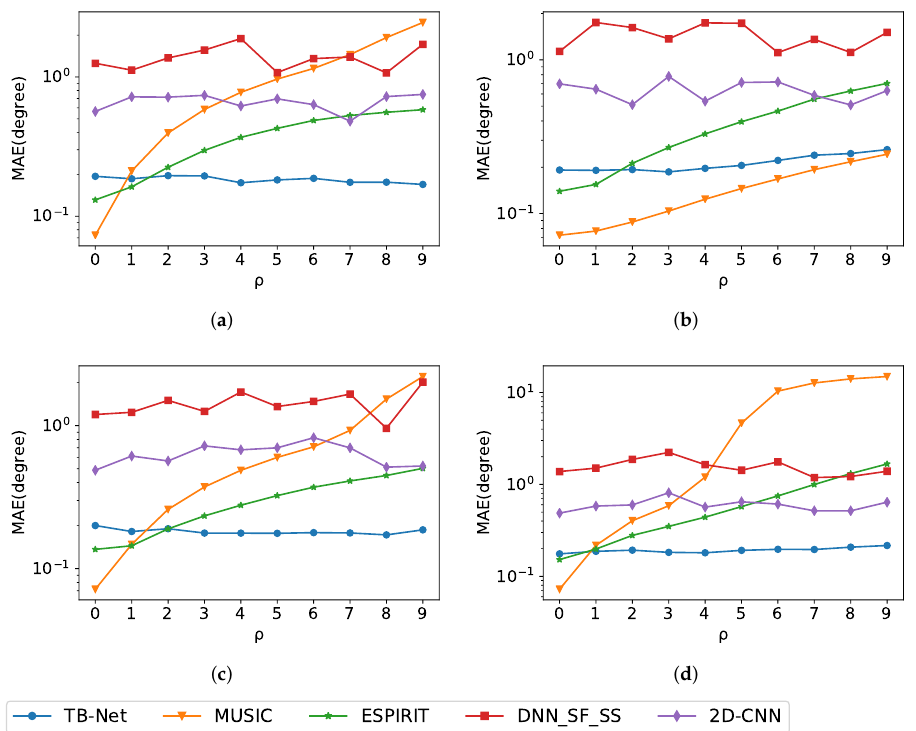
Figure 5. MAE comparison of the algorithms in the presence of different array imperfections: ( a ) combined imperfections, ( b ) mutual coupling, ( c ) deviation of antenna position, and ( d ) gain and phase